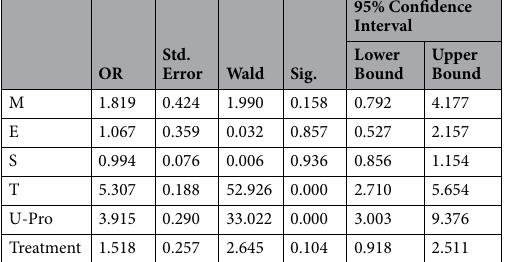
Table 2. The Multivariable logistical regression at the time of renal biopsy. M, Mesangial hypercellularity, E, Endocapillary hypercellularity, S, Segmental glomerulosclerosis, T, Tubular atrophy/interstitial fibrosis, U-Pro, urinary protein excretion; Treatment:Use of ARBs or any